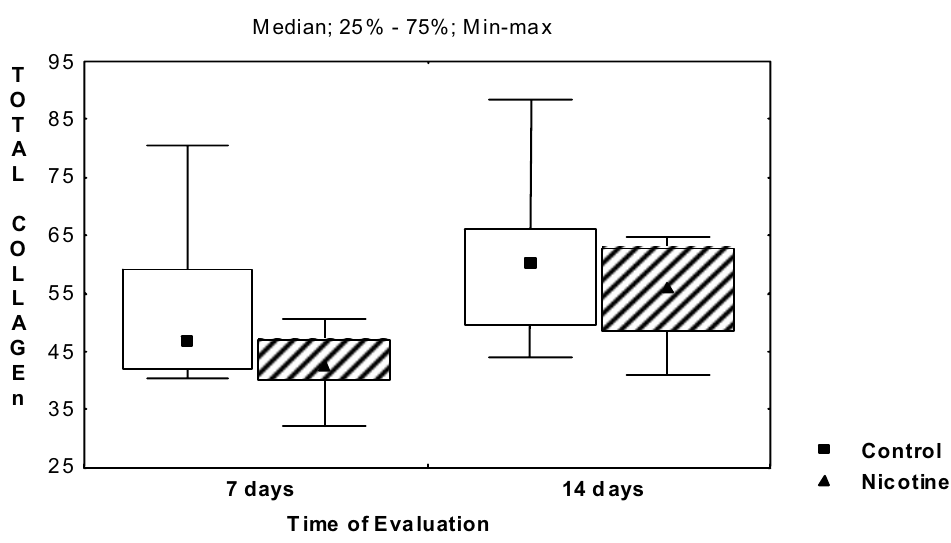
FIGURE 1 – Total collagen value, average and standard deviation